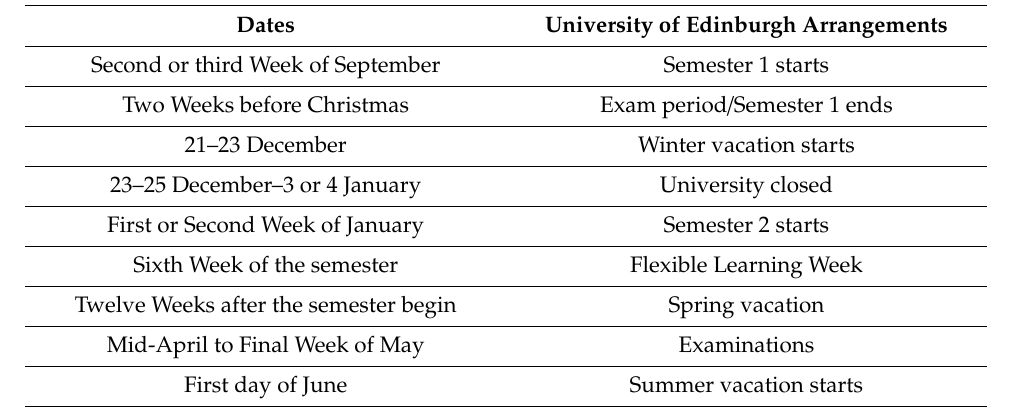
Table A2. Semester information.